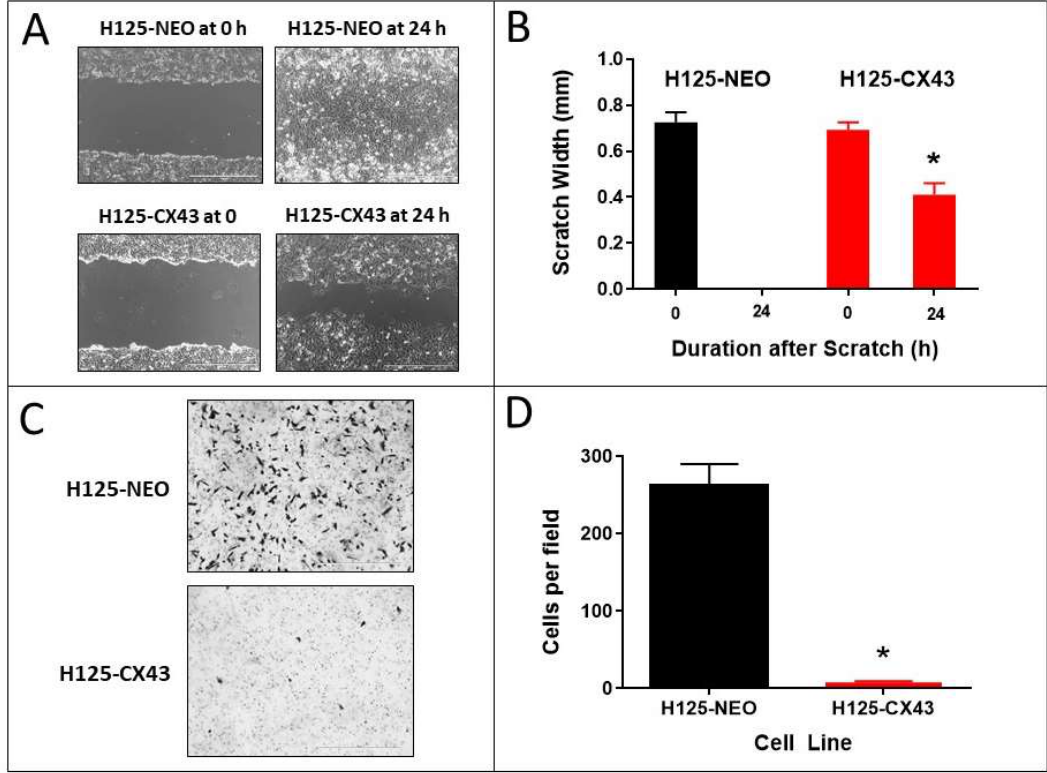
Figure 4. Connexin43 suppresses the migration and invasion of H125 cells. ( A , B ) Scratch assay of H125-NEO and H125-CX43 cells (scale bars: 1000 µm). ( C , D ) Matrigel transwell invasion with these cells (scale bars: 1000 µm). * p < 0.01 compared to H125-NEO, Student’s t -test, mean ± S.D., n = 3 replicate experiments.